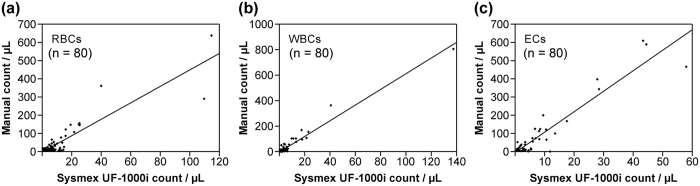
Count correlations between the Sysmex UF-1000i (μL) and manual observation with disposable chamber slide (μL) for red blood cells (RBCs), white blood cells (WBCs), and epithelial cells (ECs).(a), The equation that unified manual (μL) and Sysmex UF-1000i (μL) RBC counts was the following: Manual count = −5.468 + (5.049 × Sysmex UF-1000i count). The r value was 0.898 (P < 0.001), and the r2 value was 0.807. (b), The equation that unified manual (μL) and Sysmex UF-1000i (μL) WBC counts was the following: Manual count = 0.667 + (6.825 × Sysmex UF-1000i count). The r value was 0.977 (P < 0.001), and the r2 value was 0.955. (c), The equation that unified manual (μL) and Sysmex UF-1000i (μL) RBC counts was the following: Manual count = −7.450 + (12.559 × Sysmex UF-1000i count). The r value was 0.947 (P < 0.001); and the r2 value was 0.898.